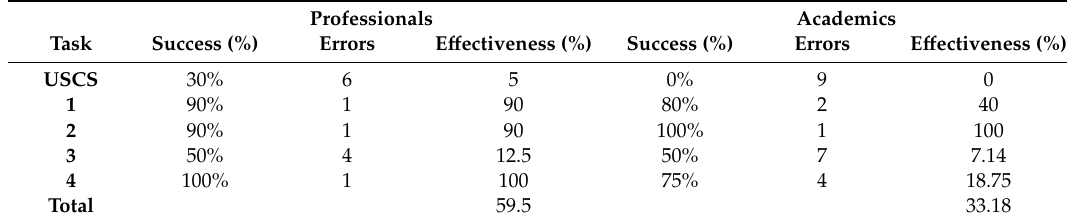
Table 3. E ff ectiveness between professionals and academics.